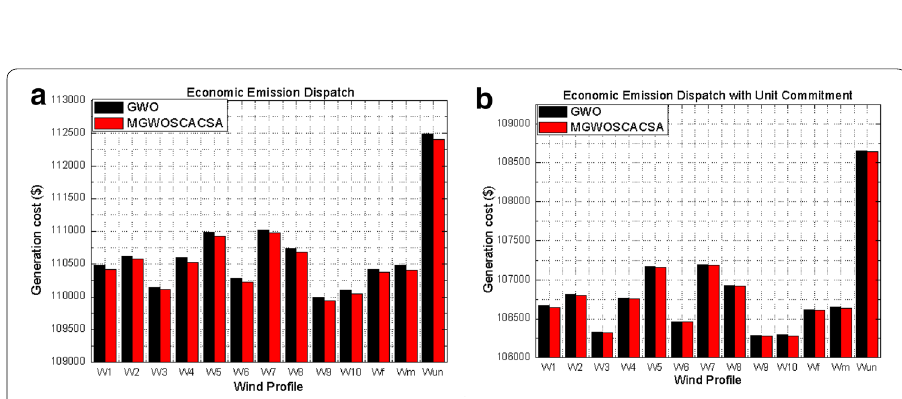
Fig. 14 EED comparison for various wind profiles a without unit commitment. b With unit